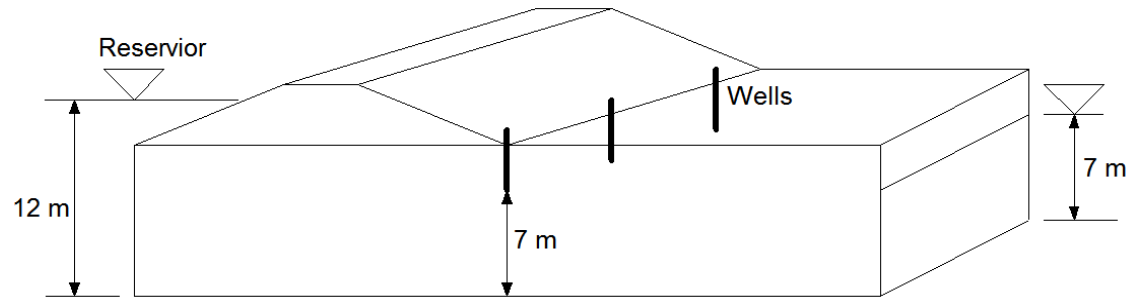
Fig. 1. Typical section of earth dam with relief wells at the toe of